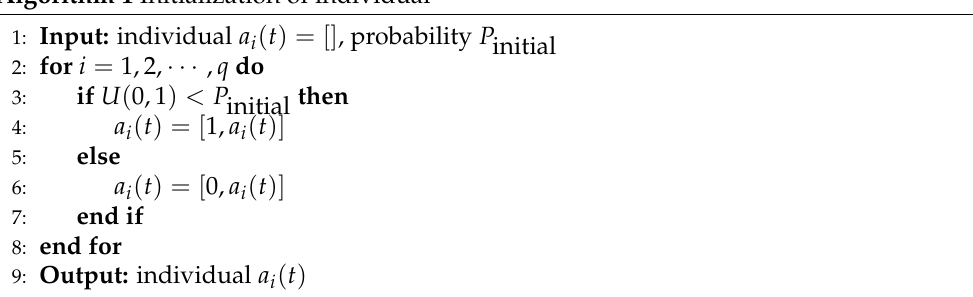
Algorithm 1 Initialization of